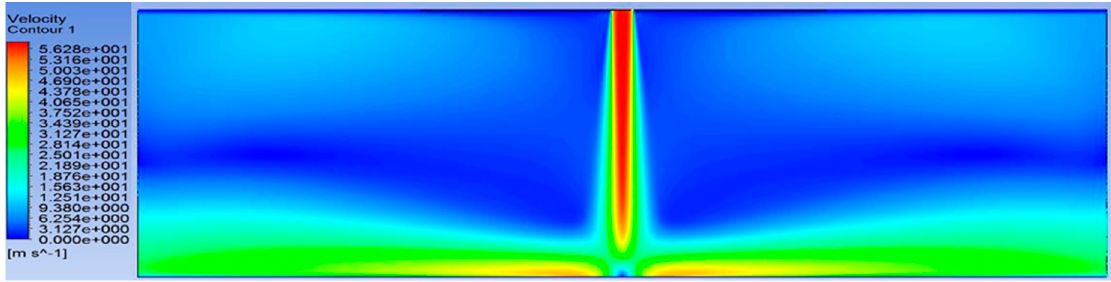
Figure 7. Velocity contours of the single slot jet at H/B = 8, Re = 1.1 × 10 4 , with k- ε model.